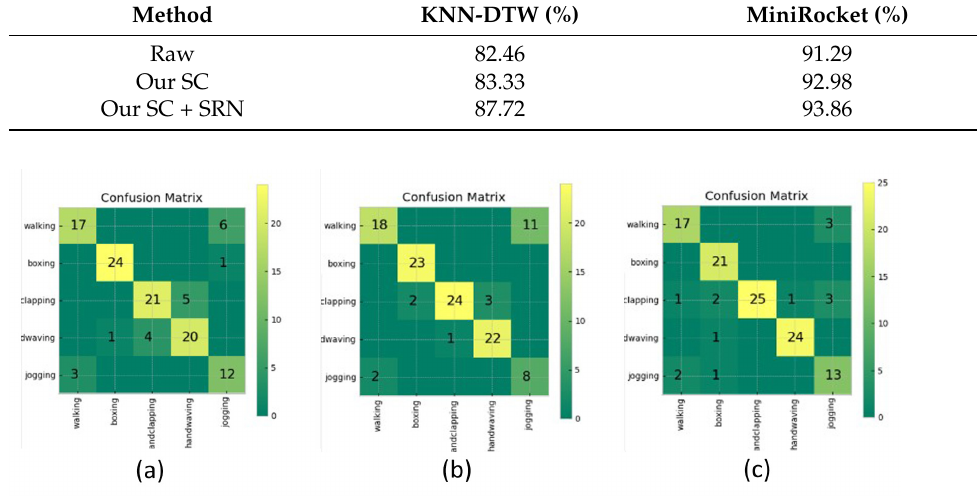
114 Table 3. Classification results for SC + SRN using KNN-DTW with KTH-5. Action Category